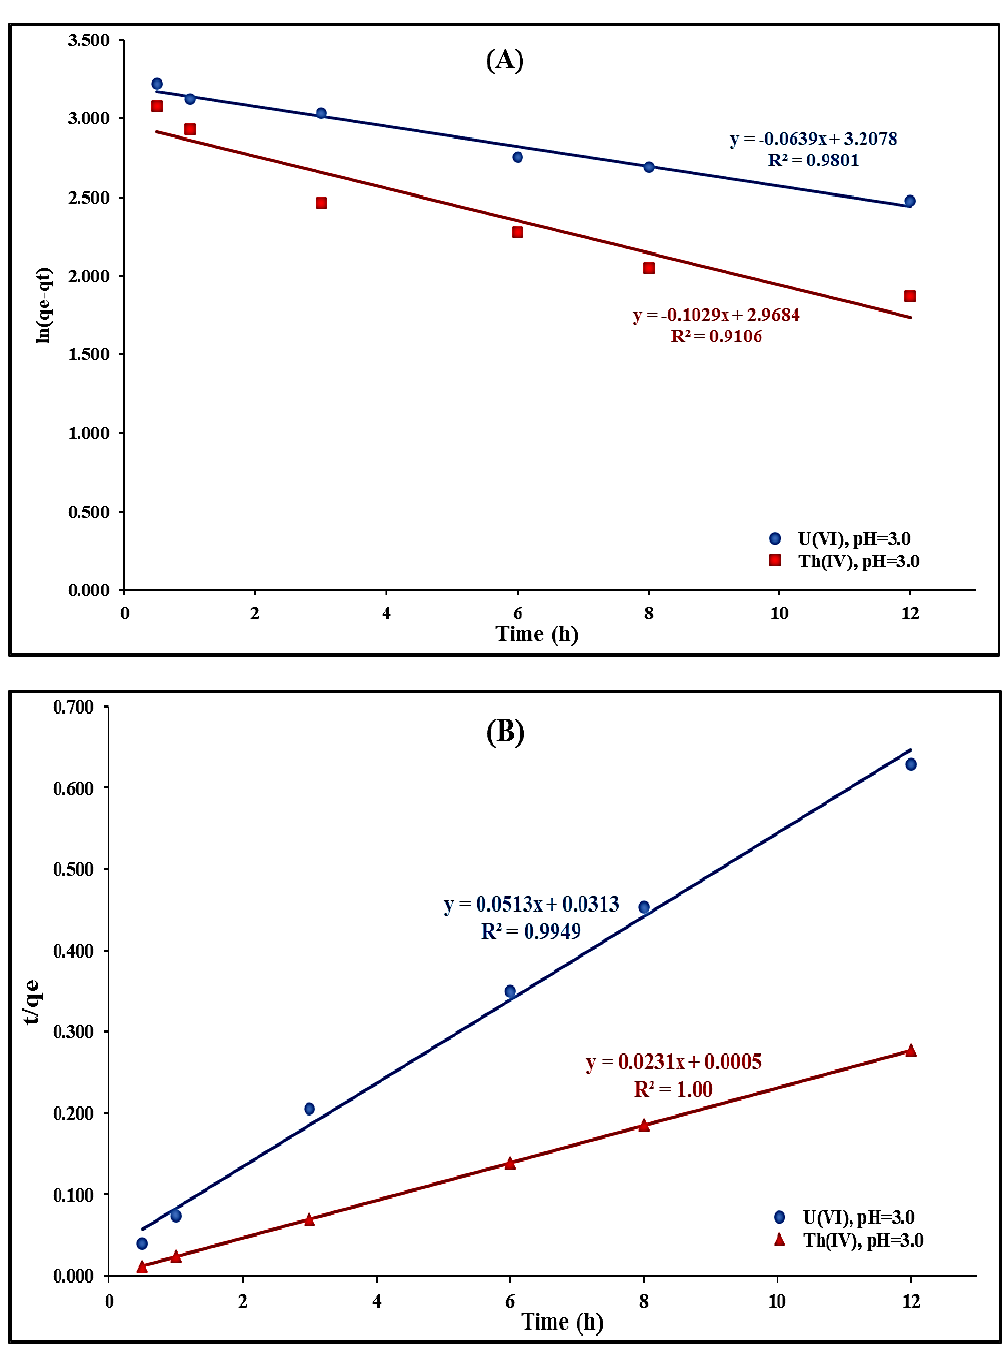
Figure 10. ( A ) Pseudo-first-order, ( B ) pseudo-second-order kinetics adsorption models of U(VI) and Th(IV) at pH =3.0 and T = 25.0 °C. Table 3. Parameters of kinetic models.